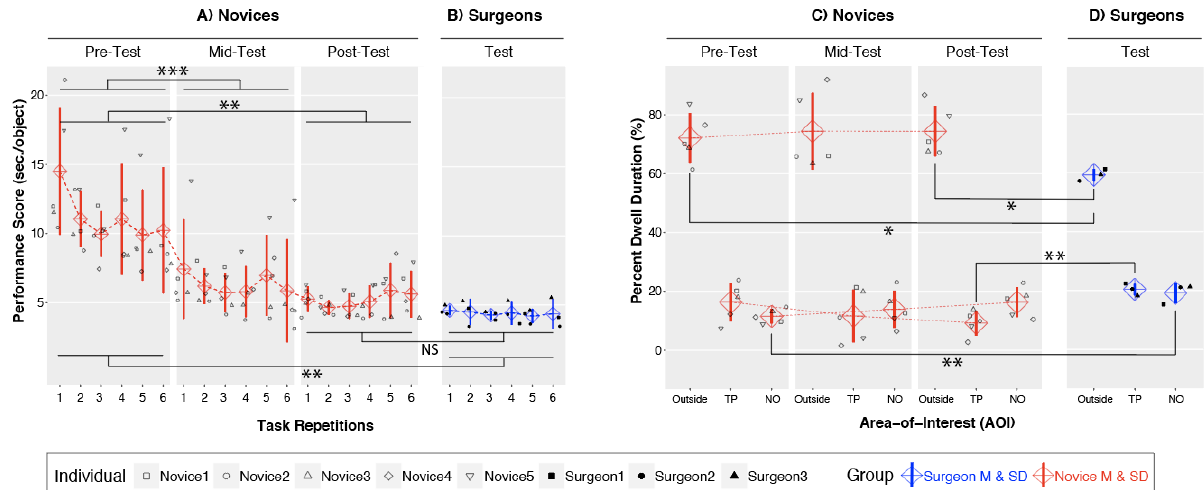
Figure 4. Behavioral performance and percent dwell duration (for both individuals and groups) with important comparisons statisti- cally marked. (A) Novice performance scores for each repetition across the pre-, mid- and post-test. (B) Surgeon performance scores for each repetition. (C) Novice percent dwell duration for each AOI shown for each testing session. (D) Surgeon percent dwell dura- tion for each AOI. *** p < .001, ** p < .01, * p < .05, NS =